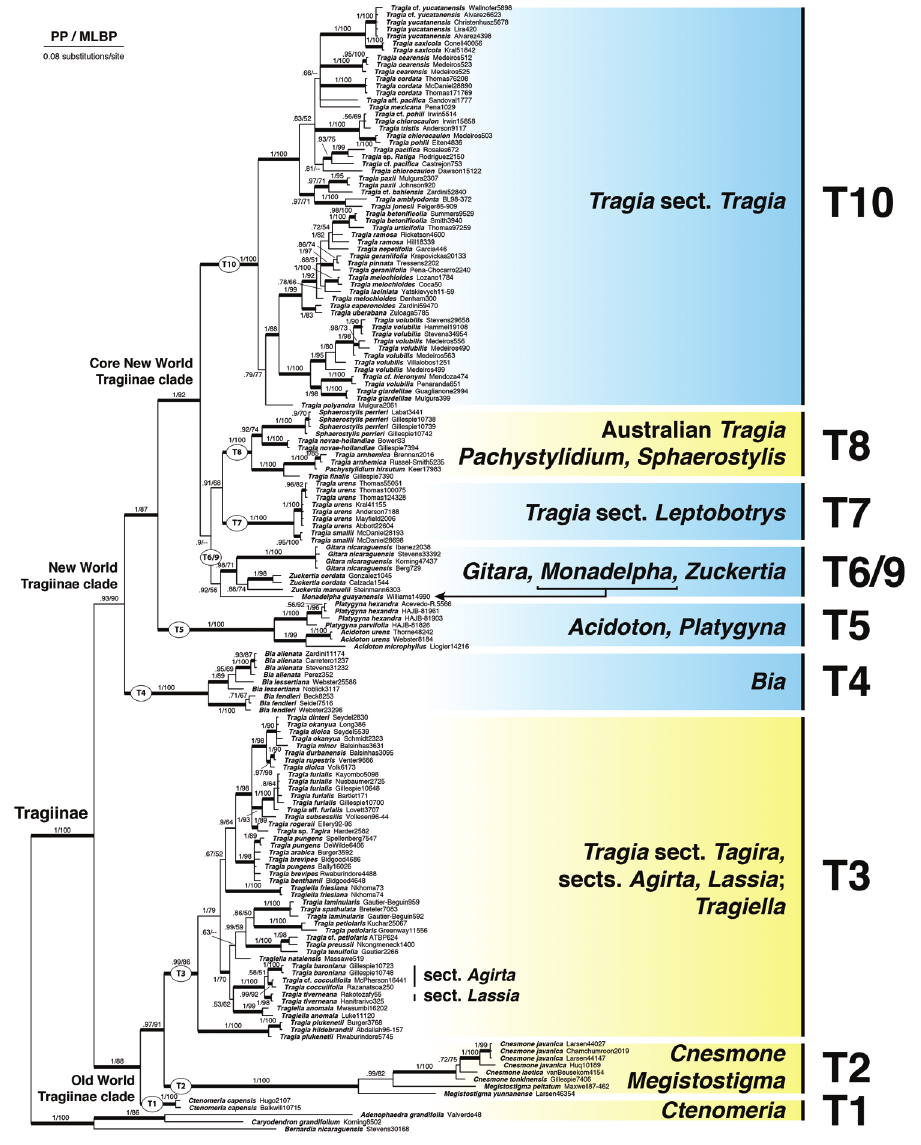
Figure 3. Phylogenetic relationships of Monadelpha . Bayesian 50% majority rule consensus tree for the 159-accession (80 taxa) ITS dataset of Tragiinae, demonstrating the distinct phylogenetic placement of Monadelpha (subclade T6/9). Subclade naming system follows Cardinal-McTeague and Gillespie (2016) with minor adjustments. Branches are labeled with Bayesian posterior probabilities (PP) and maximum likelihood bootstrap percentages (MLBP). Bold branches indicate strong support (PP >0.95, MLBP >85) and coloured boxes indicate general distribution (New World = blue, Old World =